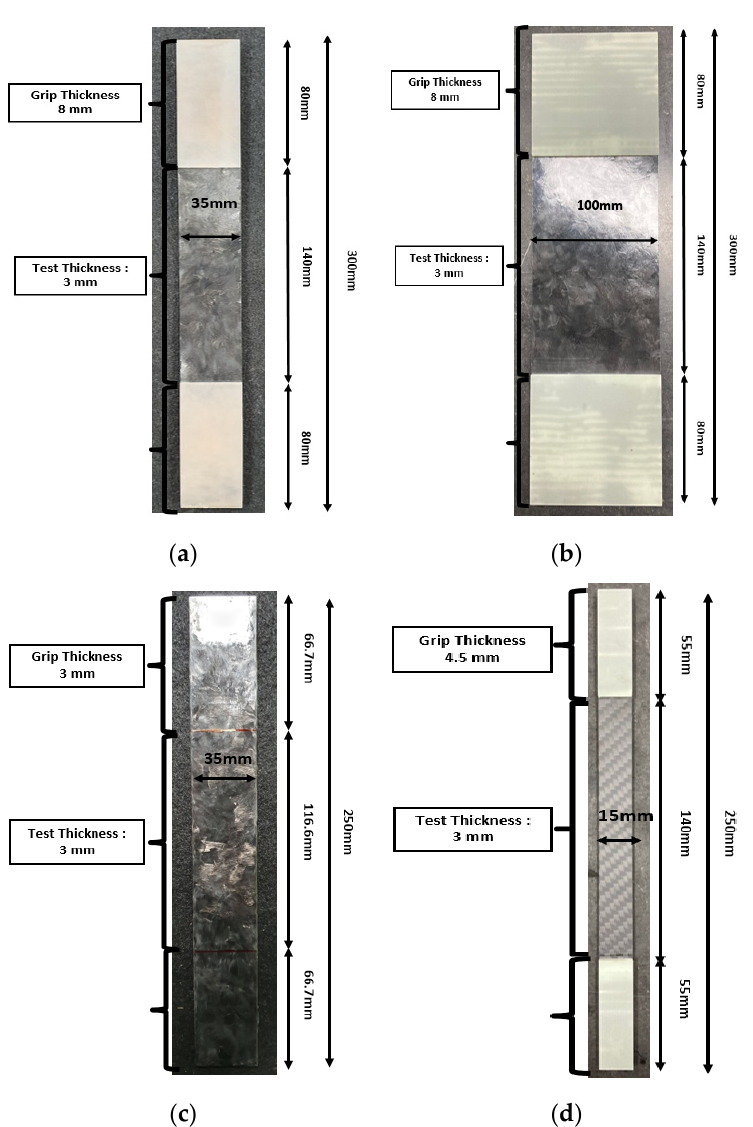
Figure 1. Test specimens for the fatigue and tensile test: ( a ) carbon sheet molding compound cut with a 35 mm width (C-SMC-Cut-35), ( b ) carbon sheet molding compound cut with a 100 mm width (C-SMC-Cut-100), ( c ) carbon sheet molding compound in mold (C-SMC-In-mold), ( d ) carbon-fiber-reinforced plastic (CFRP) .